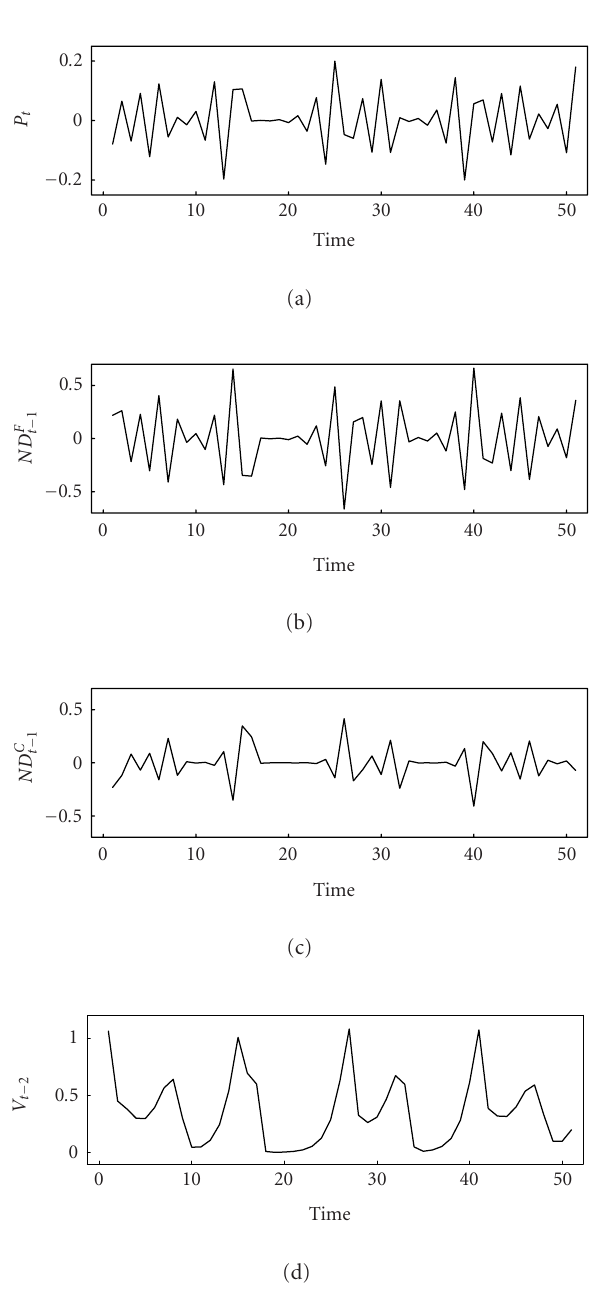
Figure 3.3. The dynamics in the time domain for N = 3 . 32. The panels in (a), (b), (c), and (d) show a sequence of 50 observations of the price in period t , the orders of the fundamentalists in period t − 1, the orders of the chartists in period t − 1, and the trading volume in period t − 2,